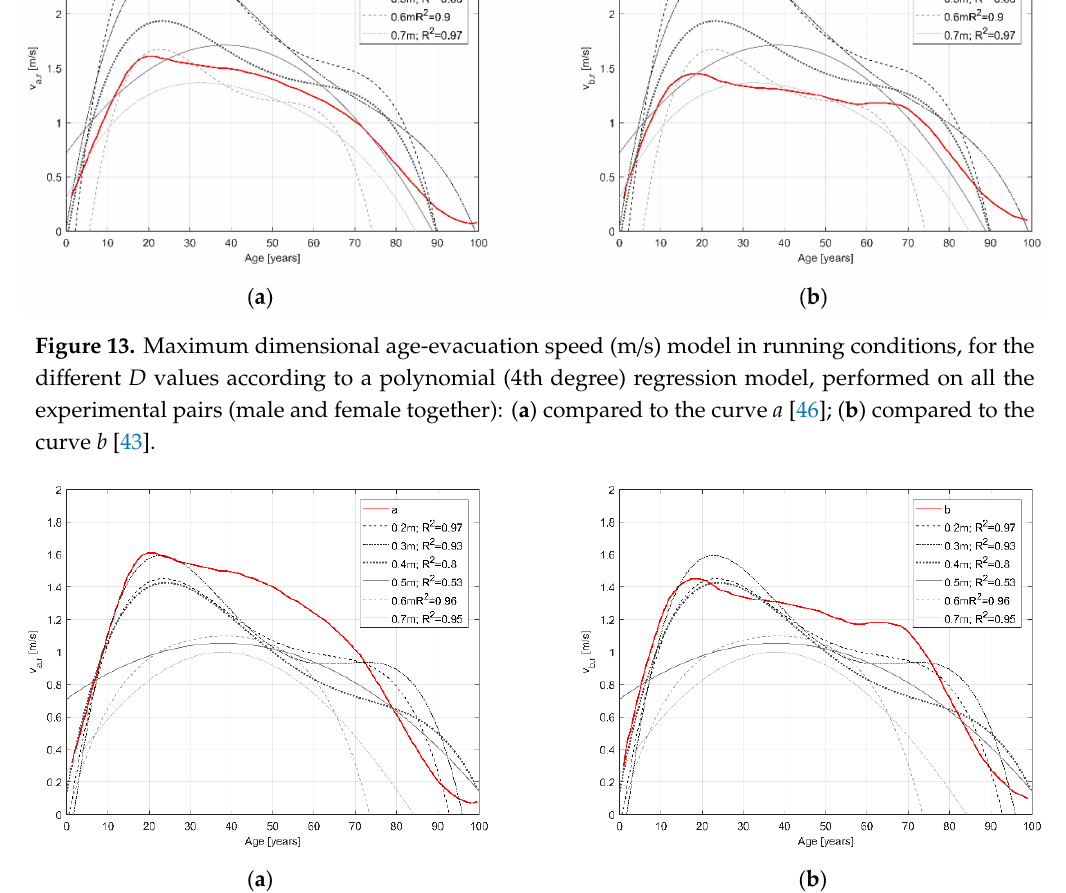
Figure 14. Average dimensional age-evacuation speed (m/s) model in walking conditions, for the different D values according to a polynomial (4th degree) regression model, performed on all the experimental pairs (male and female together): ( a ) compared to the curve a [46]; ( b ) compared to the curve b [43].